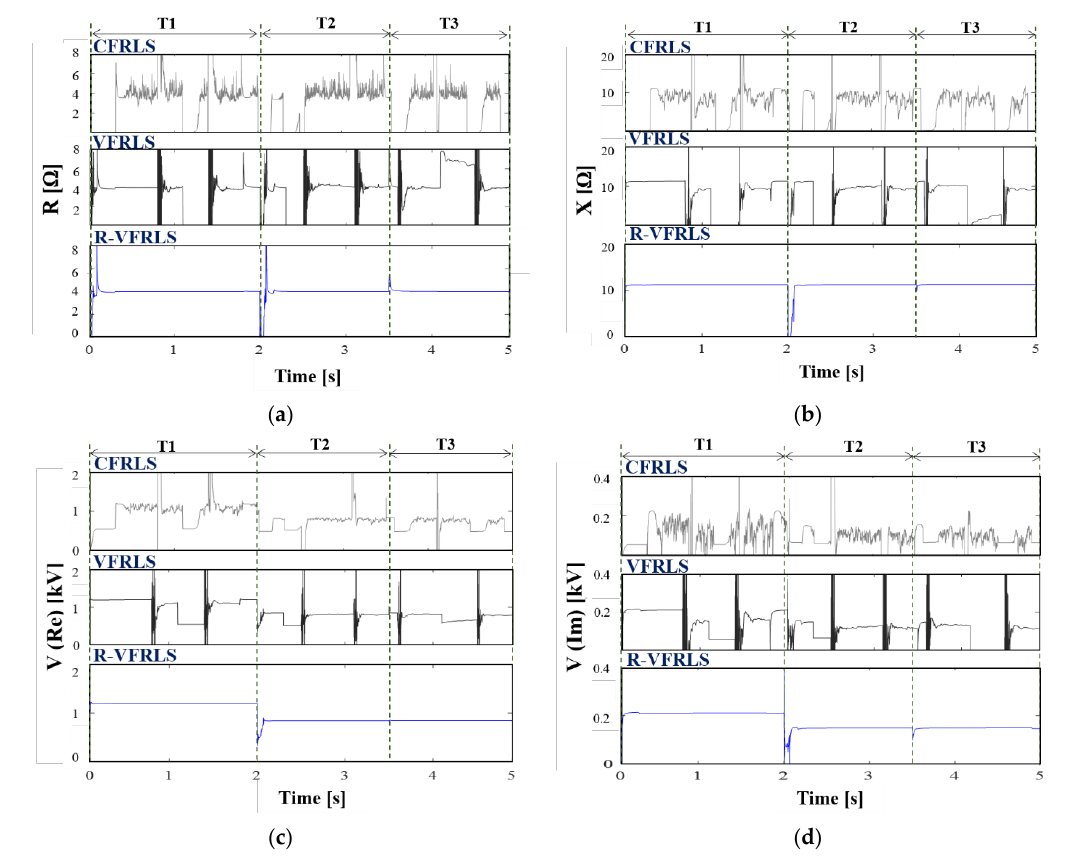
Figure 11. The results of the 3rd harmonic parameter estimation for customer 1 by the CFRLS, VFRLS, and proposed method. ( a ) Resistance. ( b ) Reactance. ( c ) The real value of voltage. ( d ) The imaginary value of voltage. Table 3. The comparison of 3rd harmonic equivalent parameter estimates for customer 1.